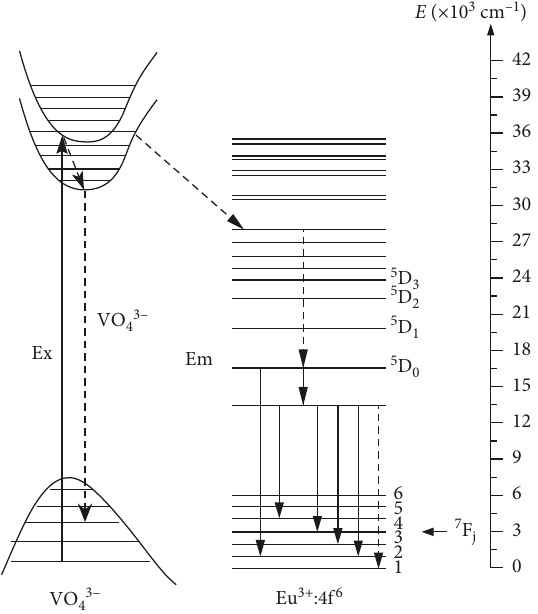
Figure 2: TEM micrographs and the size distribution diagram of YVO stirring (b).